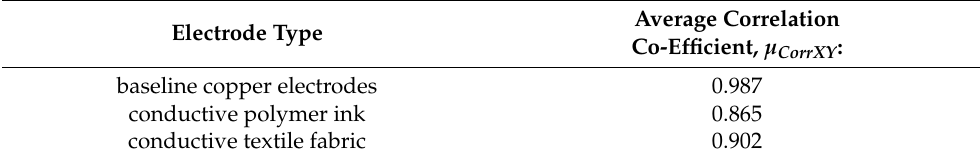
Figure 15. Waveform averaging of the human ECG for ( a ) baseline copper electrodes; ( b ) conductive polymer ink; ( c ) conductive textile fabric. Table 2. Average correlation coefficients.